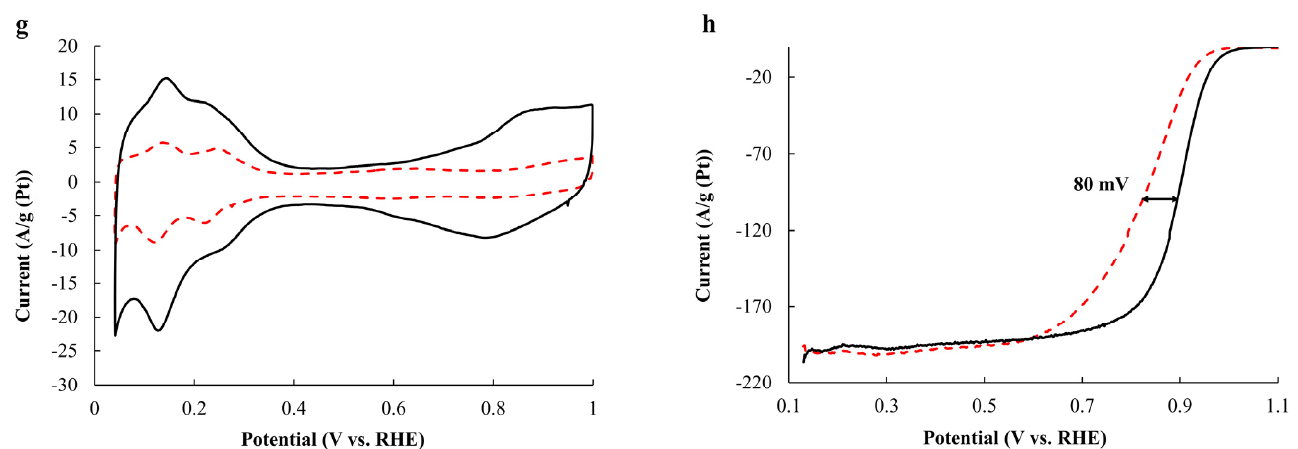
Figure 6. The cyclic voltammograms ( a , c , e , and g ) and the linear sweep voltammograms ( b , d , f , and h ) of the АС , АС _acid, and АС _350 samples and the JM40 catalyst before (the solid line) and after (the dashed line) 2000 cycles in a potential range of 0.6–1.4 V.